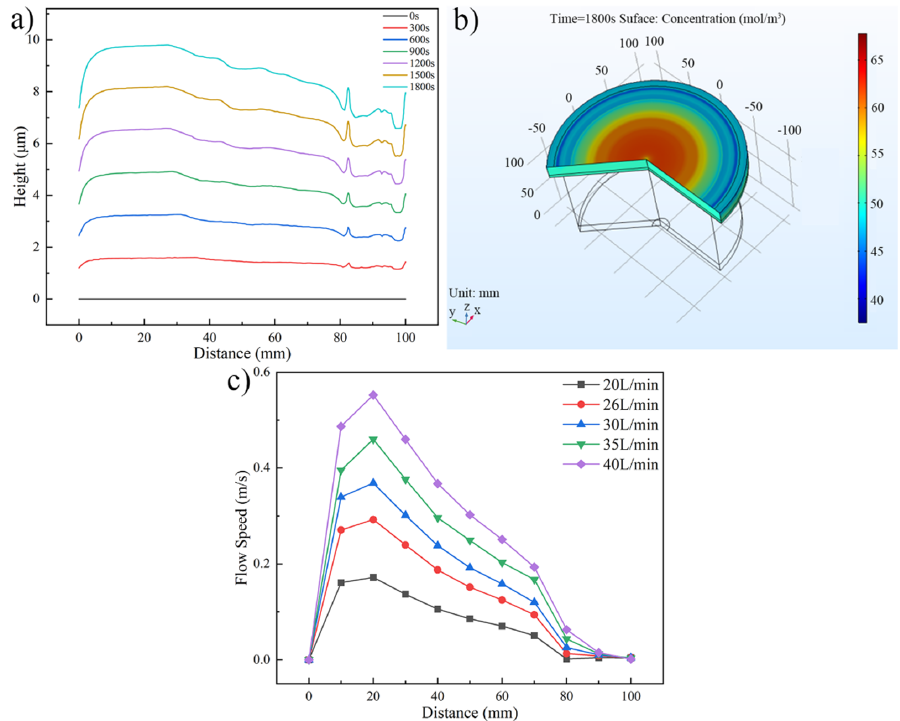
Figure 6. Distributions of the Au bump height, Au+ concentration and flow speed. ( a ) Au bump height distribution along the wafer radius (inlet flow is 40 L/min), ( b ) Au+ concentration distribution on the wafer surface (inlet flow is 40 L/min), and ( c ) flow speed distribution on the wafer surface at different inlet flows.